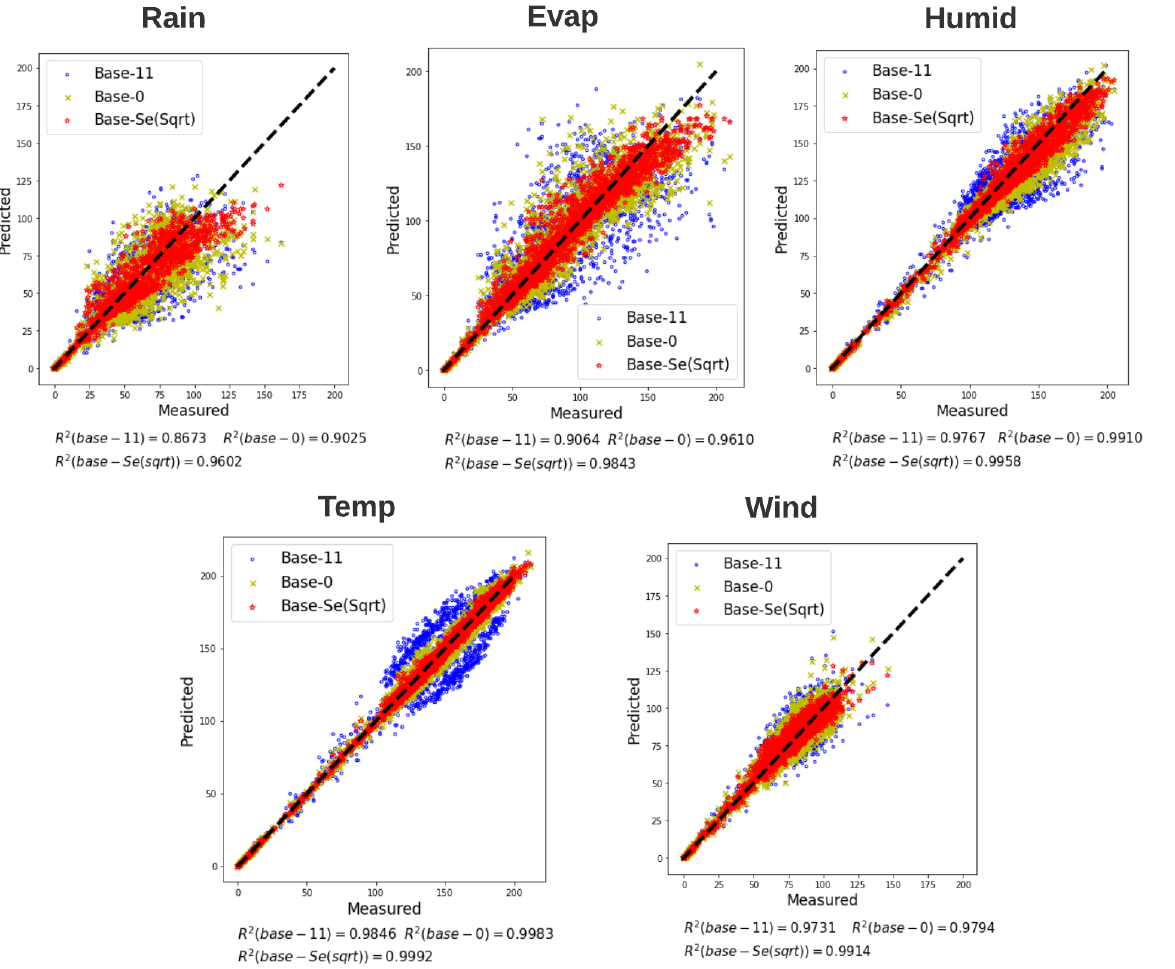
Figure 6. Residual plots and R 2 values for three proposed baselines on five different parameters. The scatter plots show 5000 randomly-selected point for each baseline, for each